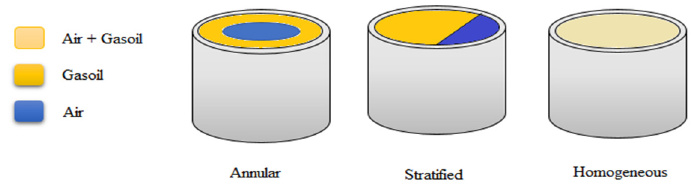
Figure 1. The flow regimes considered in the